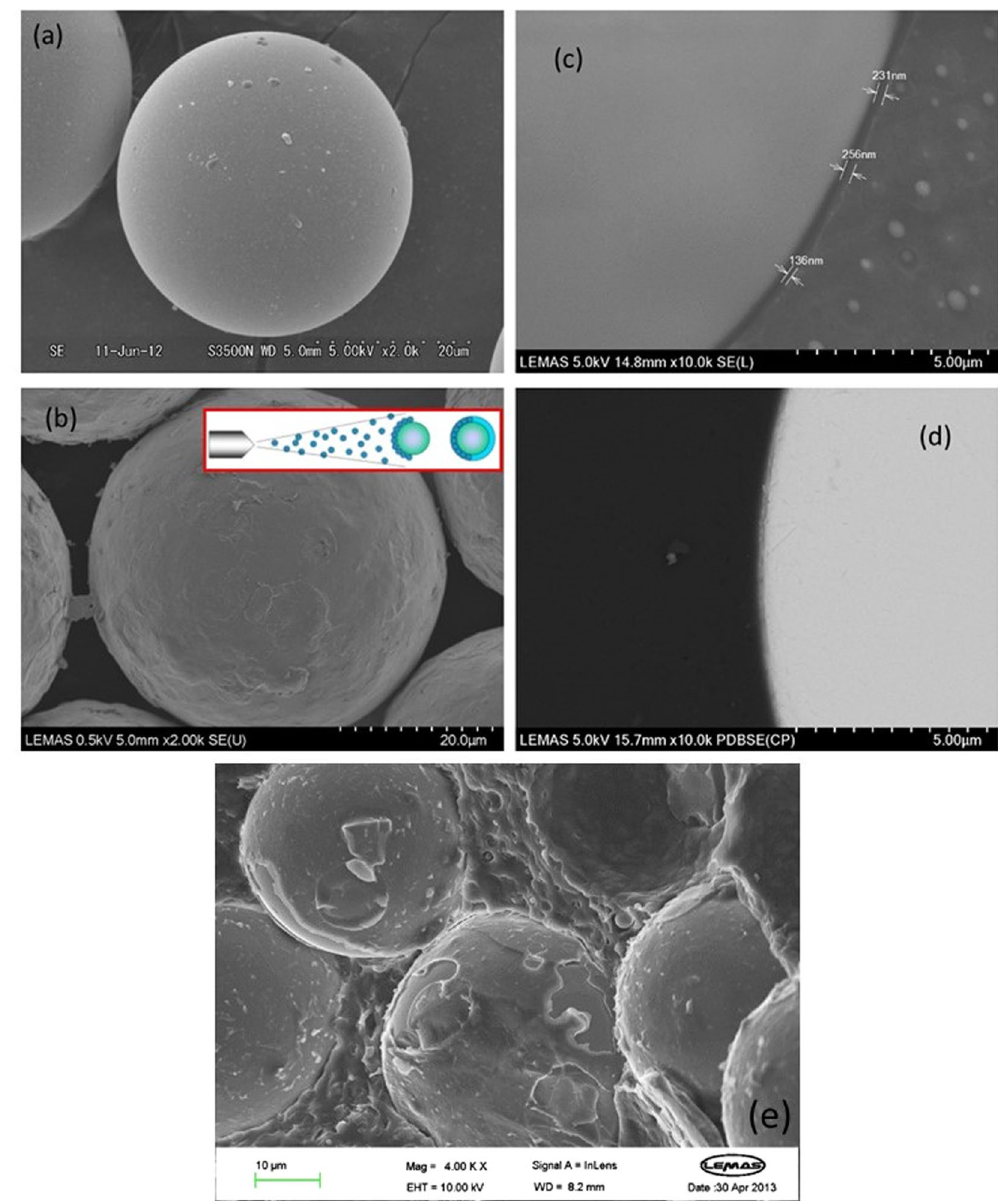
Figure 2. Scanning electron microscope images of the barium titanate beads and details of the viscoelastic coating layer. ( a ) The as received uncoated beads, average diameter = 42 μ m. ( b ) A typical bead after spray coating using a water emulsion of the coating. ( c ) Higher magnification picture of a coated bead embedded in PS suggesting a layer thickness of 200 nm. ( d ) An alternative contrasting technique confirming the layer thickness. ( e ) A freeze fracture surface from the final composite again confirming the presence of the layer after